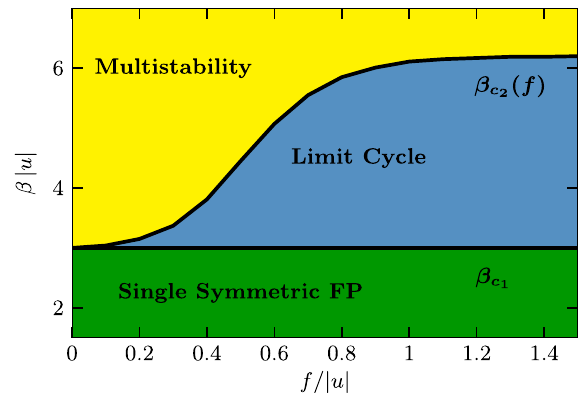
FIG. 2. Phase space in the MF varying the parameters β and f in units of u . The black lines correspond to the set of critical points β f Þ . and β c 1 c 2 ð